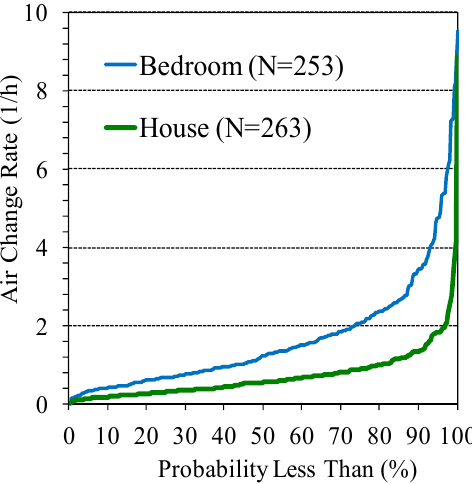
Figure 2. Cumulative distributions of ACRs in houses and